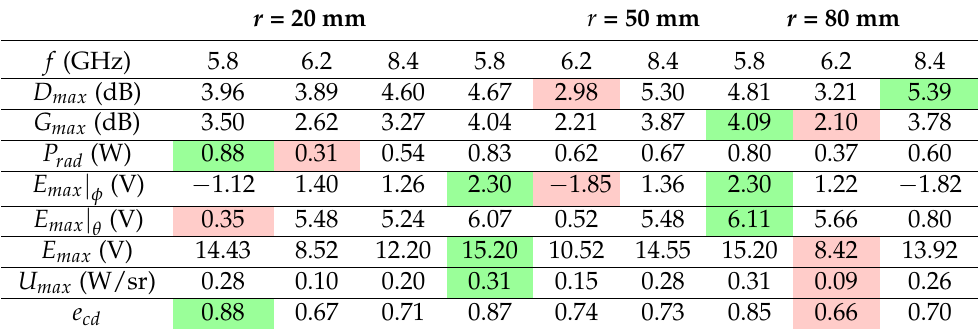
(total input power is set as 1 W), maximum θ component of E-field E max | total electric field E max , maximum radiation intensity U max , and radiation efficiency e cd . The optimal results among the tests are highlighted in green. Conversely, the minimum values are in red. Table 1. The antenna parameters for conformal